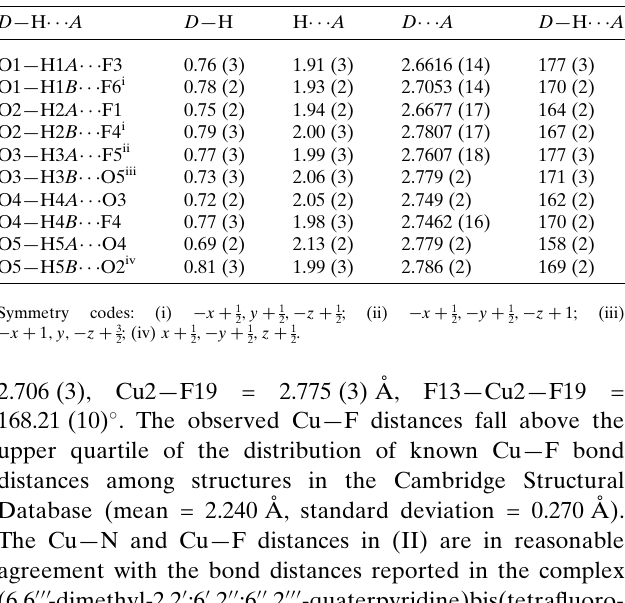
Table 1 Hydrogen-bond geometry (A˚ , (cid:4) ) for